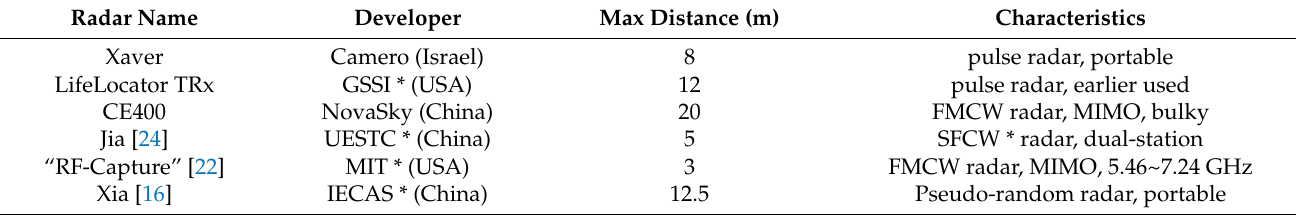
Table 1. The maximum detection range of typical radars around the world. Developer